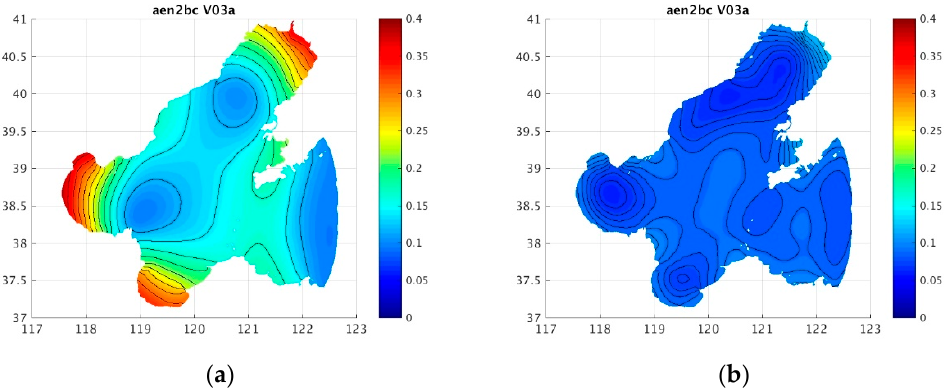
Figure 7. M 2 water level uncertainty field (m) from boundary condition and tidal forcing data assimilation. ( a ) prior error distribution of the model state variable, water level. ( b ) posterior error distribution.